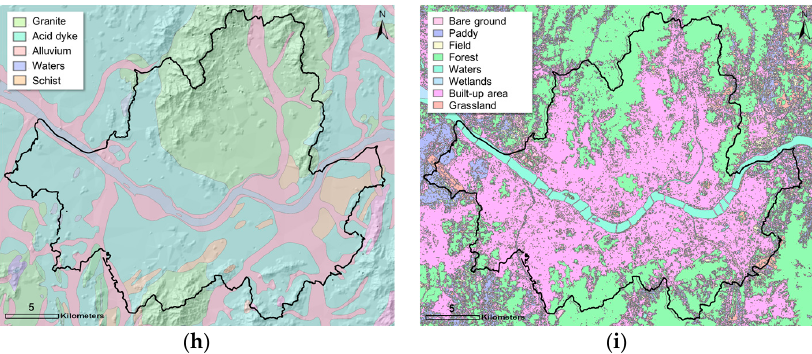
Figure 2. Big data platform for the Seoul metropolitan area consisting of multiple geological datasets: ( a ) three-dimensional bird’s-eye view overlaid with multiple geo-layers; ( b ) digital elevation model (DEM) and watershed; ( c ) administrative boundary; ( d ) borehole and site survey information; ( e ) road and railroad information; ( f ) building information; ( g ) pipeline information; ( h ) geological map with DEM; and ( i ) land cover map.